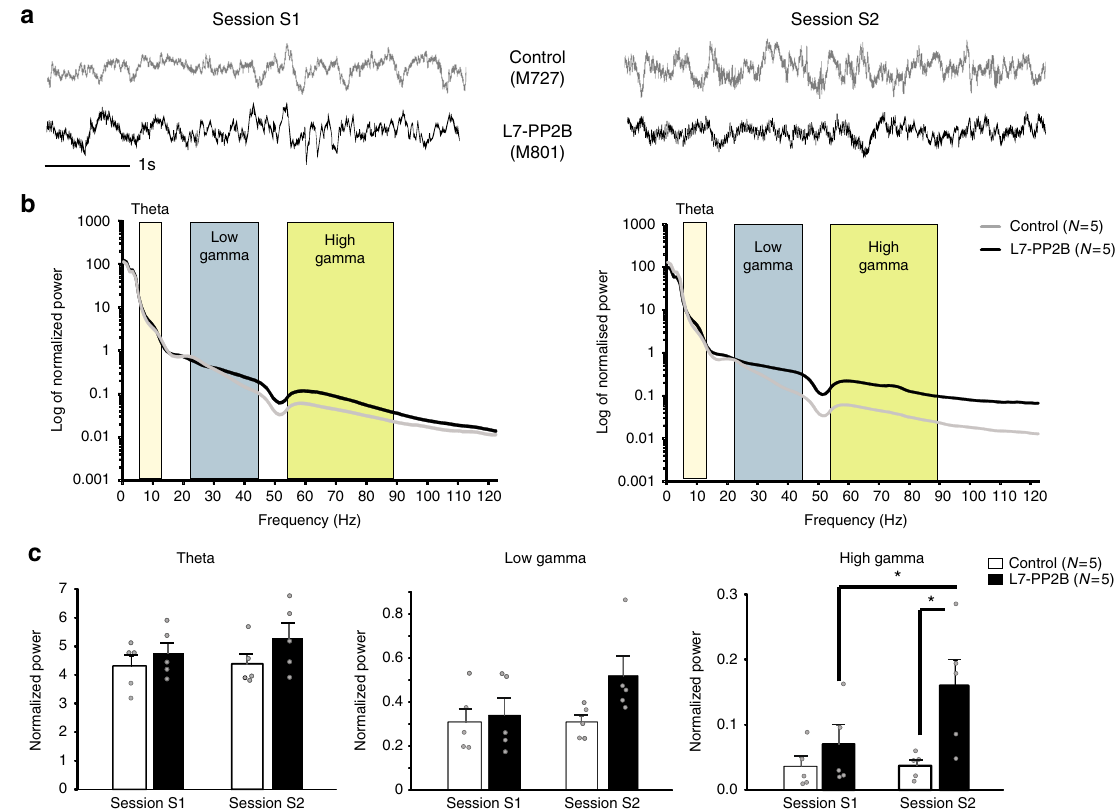
Fig. 5 L7-PP2B mice have higher high gamma power than controls upon reentry in the arena. a Raw traces from one L7-PP2B mice and one control mice during S1 and S2. b Average power spectrum normalized by total power in the 1 – 120 Hz frequency range computed over exploration epochs. c Barplots showing the normalized power of the theta (6 – 12 Hz, repeated measure ANOVA, genotype, F (1,8) = 1.24, p = 0.30; session, F (1,8) = 2.44, p = 0.16; genotype*session interaction, F (1,8) = 0.31, p = 0.59), low gamma (20 – 45 Hz, repeated measure ANOVA, genotype, F (1,8) = 1.96, p = 0.20; session, F (1,8)